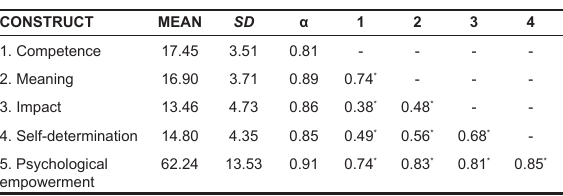
TABLE 5 Descriptive statistics, Cronbach alpha coefficients and intercorrelations of the